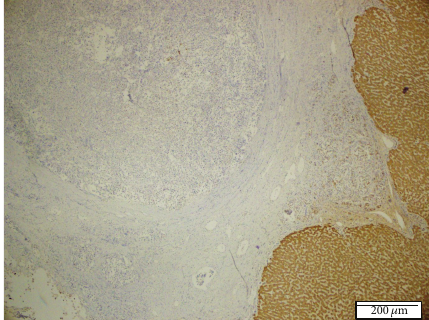
Figure 7: Negative immunoreactivity for Heppar-1 in tumor cells; in contrast positive immunoreactivity occurs in normal liver cells in the resected liver specimen. IHC staining, × 40.